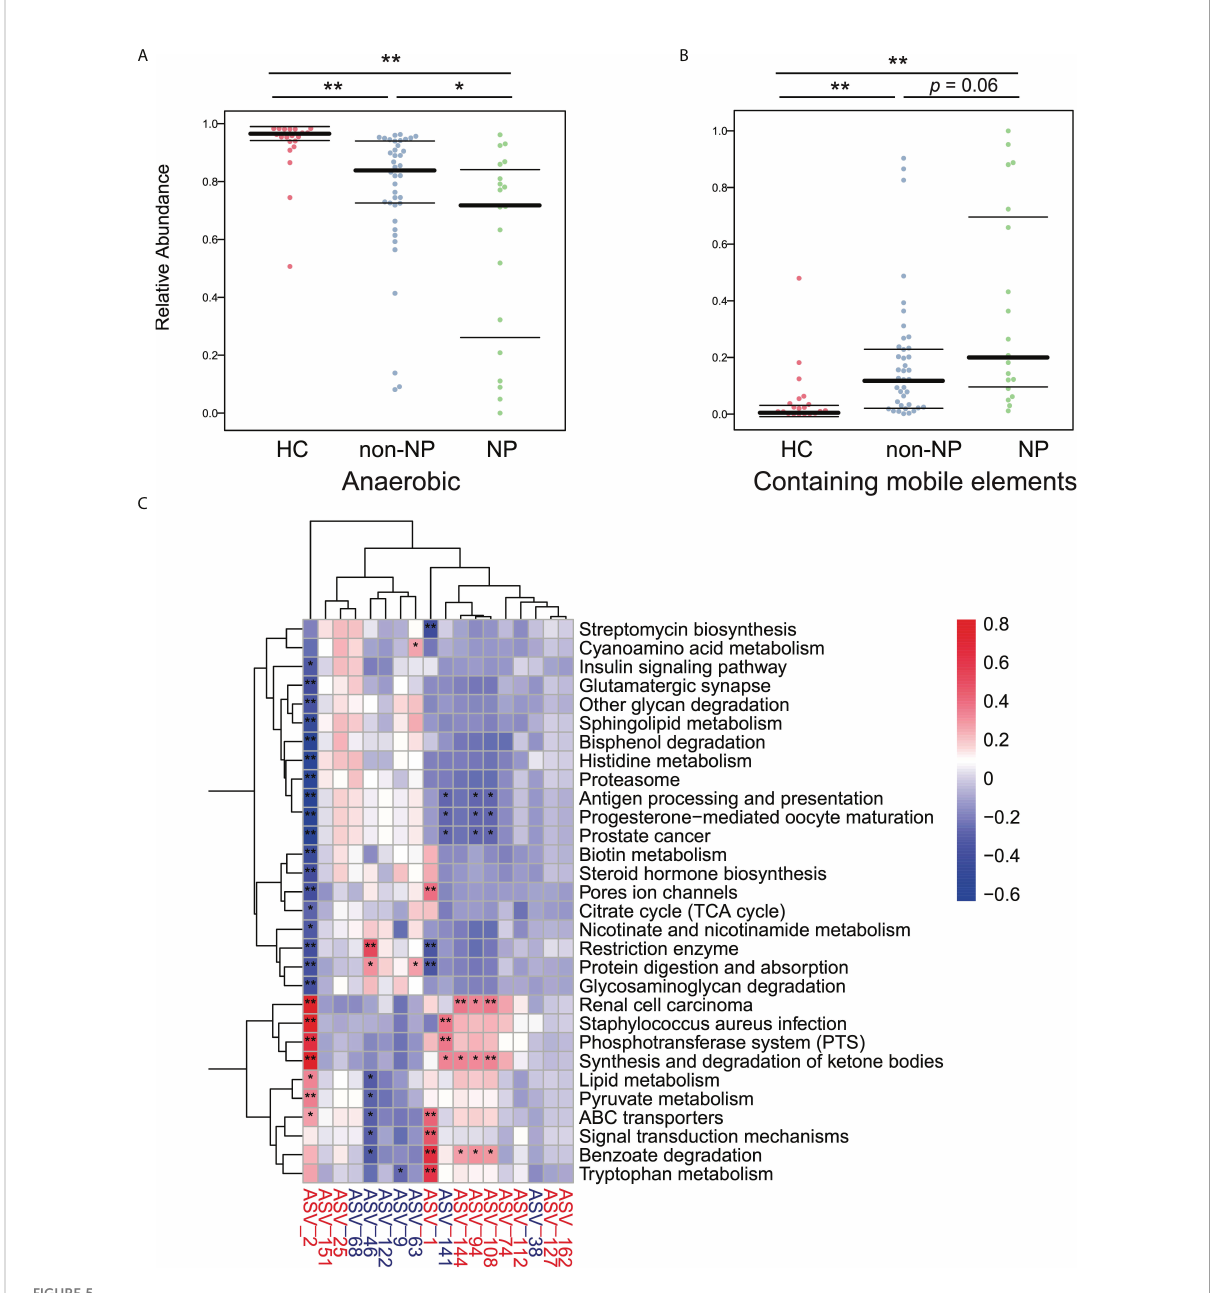
FIGURE 5 Predicted phenotypes of intestinal micro fl ora in the NP, non-NP and HC groups. (A, B) Predicted relative abundance of anaerobic bacteria and bacteria containing mobile elements based on the BugBase database. * p < 0.01, * p < 0.05, ns, not signi fi cant, by pairwise Mann-Whitney- Wilcoxon tests. (C) Spearman correlations were calculated between pathways predicted by PICRUSt2 that differed between the the NP and the non-NP groups and differential ASVs. Rows: Differential pathways predicted by PICRUSt2 between the NP and NNP groups; Columns: Differential ASVs. ASVs highlighted in red were enriched in the NP group, and ASVs highlighted in blue were depleted. * p < 0.05, ** p <